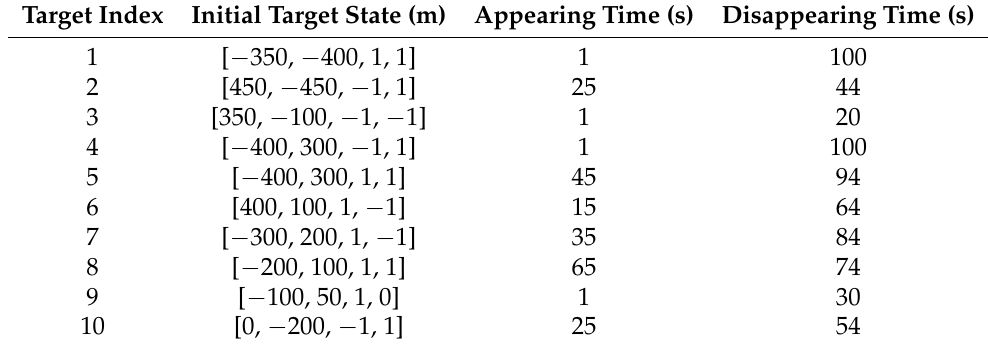
Table 1. The detailed parameters of targets in the birth